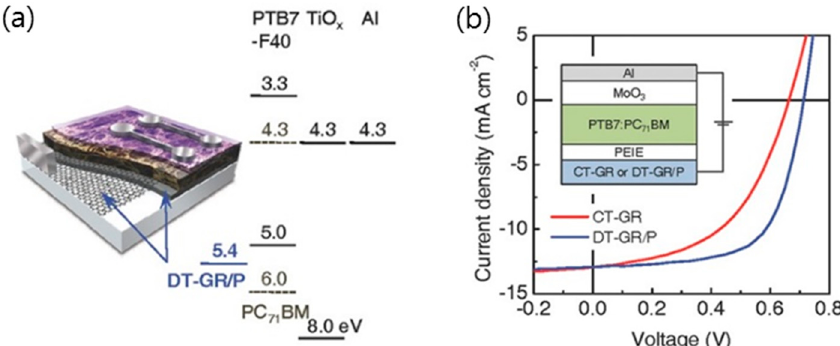
Figure 12. ( a ) Schematic illustrating the structure and corresponding energy-level diagram of the fabricated conventional structure perovskite solar cells (PSC). For some of the devices, an additional PEDOT:PSS layer (AI 4083, 30 nm) was used with the doping transfer-graphene (DT-GR)/P electrode. ( b ) The current density-voltage (J–V) characteristics of the best inverted structure PSCs with the conventional transfer (CT)-GR (red line) and the DT-GR/P (blue line) electrodes. The inset represents the device structure of the inverted PSCs. Reproduced with the permission of Reference [60].